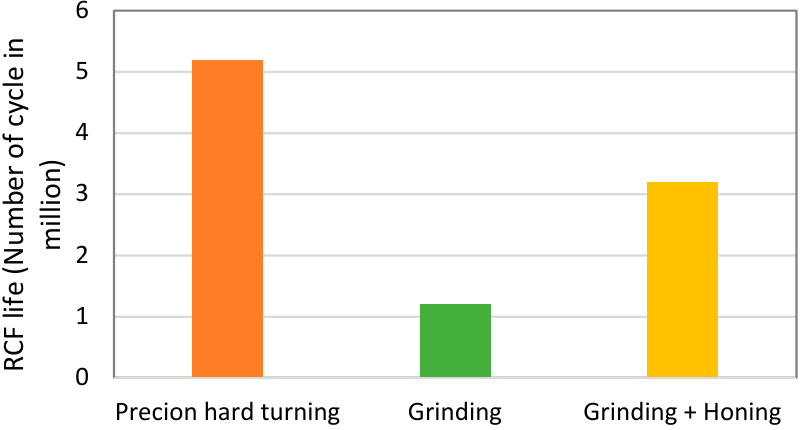
Figure 9. RCF life vs. finishing processes.